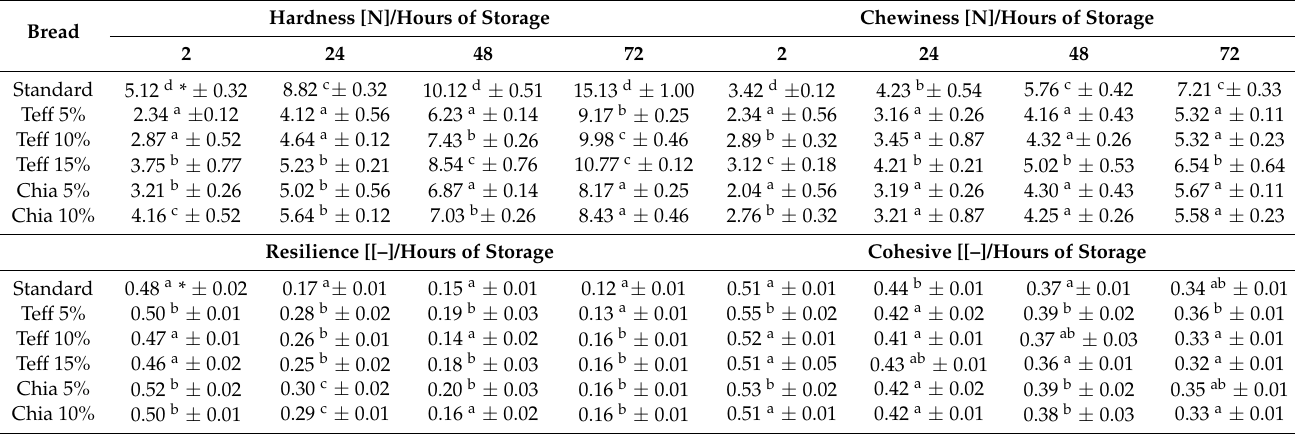
Table 3. Textural parameters of the tested bread during